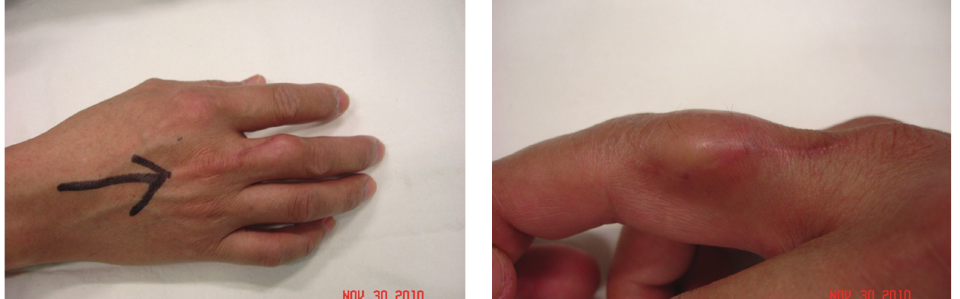
Figure 2: Gross picture four months after the injury. There is a mass at the radio-dorsal aspect of the proximal middle phalanx.